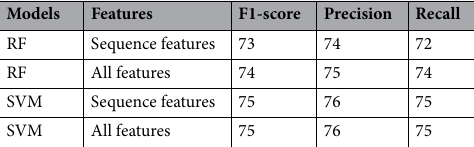
Table 2. Performance of SVM and random forest without feature selection using tenfold